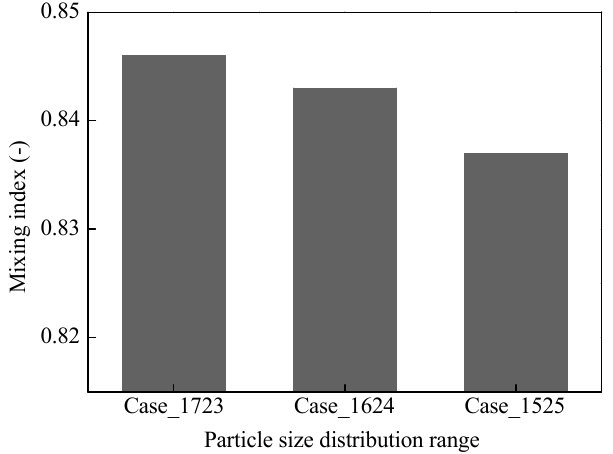
Figure 14. Time-averaged mixing index in the system with different particle size distributions.